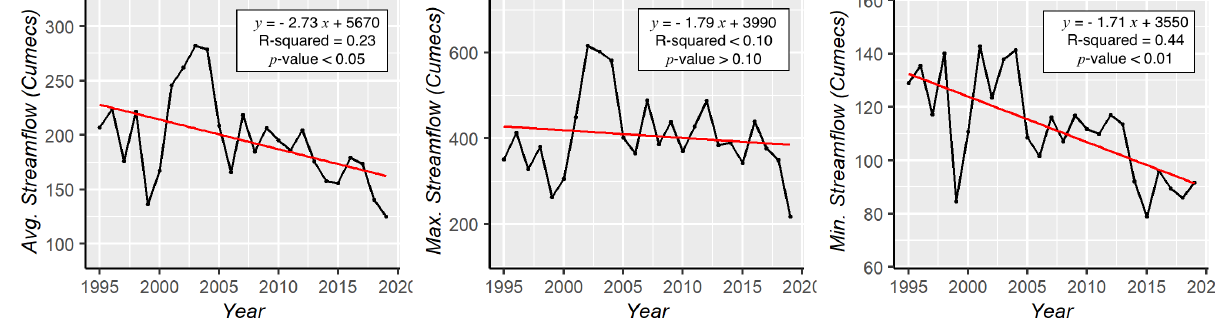
Figure 7. Linear regression trends of annual